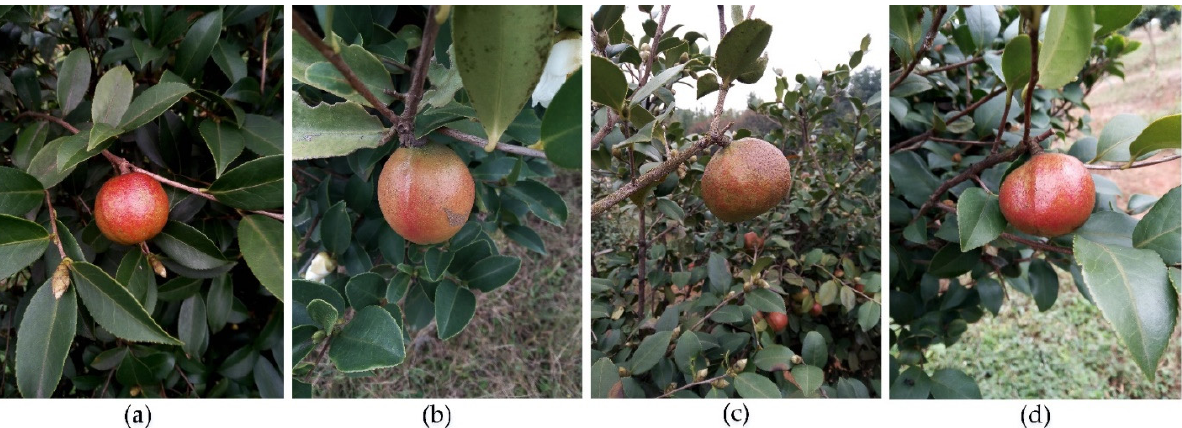
Figure 1. Sample image examples of the four oil tea cultivars: ( a ) Xianglin 210; ( b ) Huajin; ( c ) Huashuo; ( d ) Huaxin.